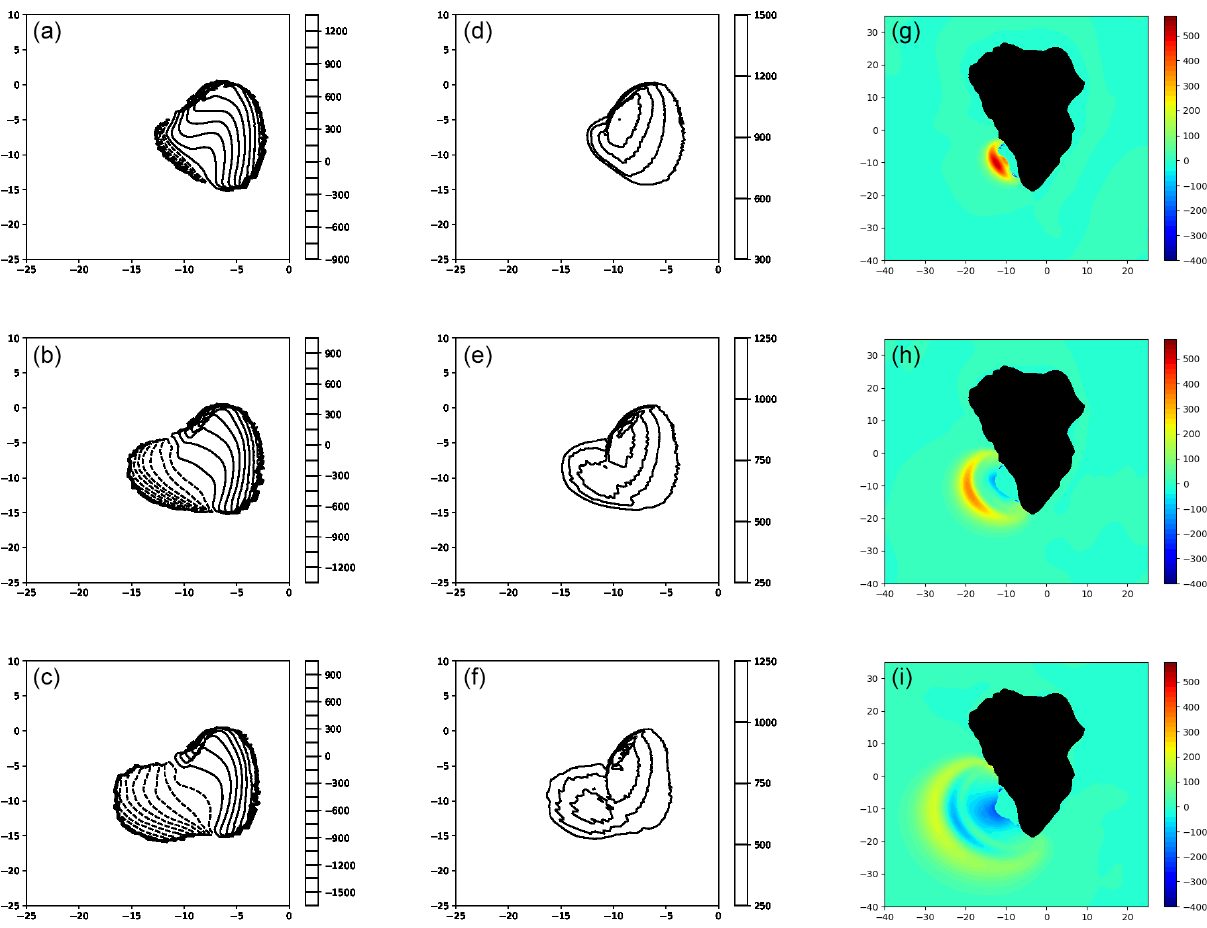
Figure 9. Snapshots of slide upper free surface, thickness and corresponding water-free surface for the present study (i.e., viscous slide with a viscosity of 2 × 10 7 Pas; a–c , d–f and g–i ) for the 80km 3 scenario at t = 60s (a, d, g) , 120s (b, e, h) and 180s (c, f, i) .